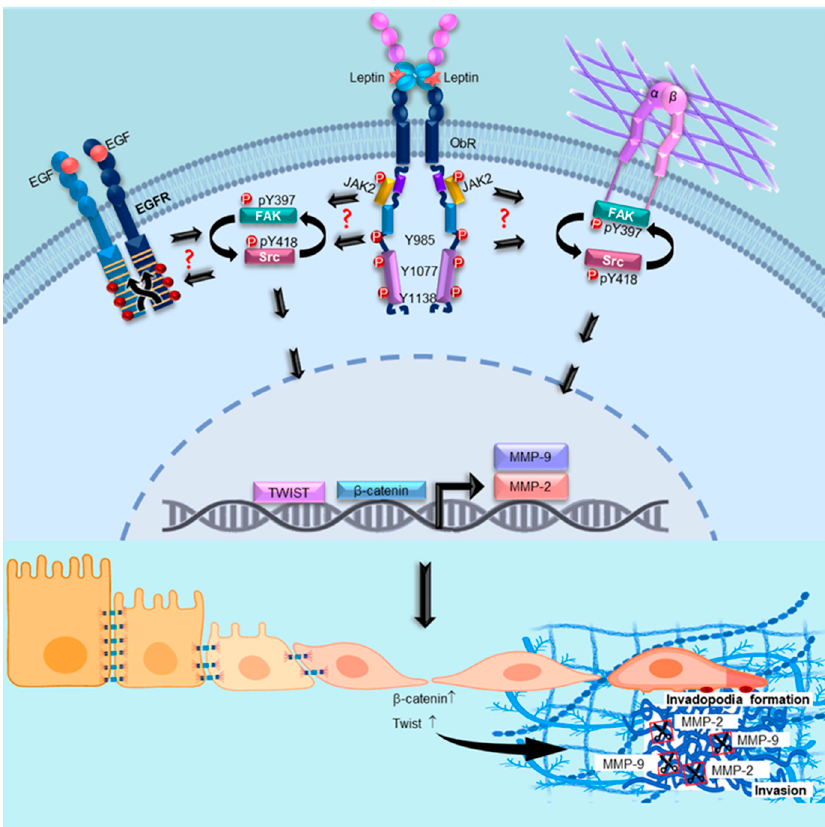
Figure 8. Model for leptin-induced EMT via Src and FAK signaling pathways. Leptin activates FAK and Src in a positive feedback pathway, which in turn regulate the expression and subcellular localization of β -catenin and Twist, promoting the expression of MMP-2 and MMP-9 as well as EMT-related events such as invadopodia formation and cell invasion. ? indicates an unknown mechanism.